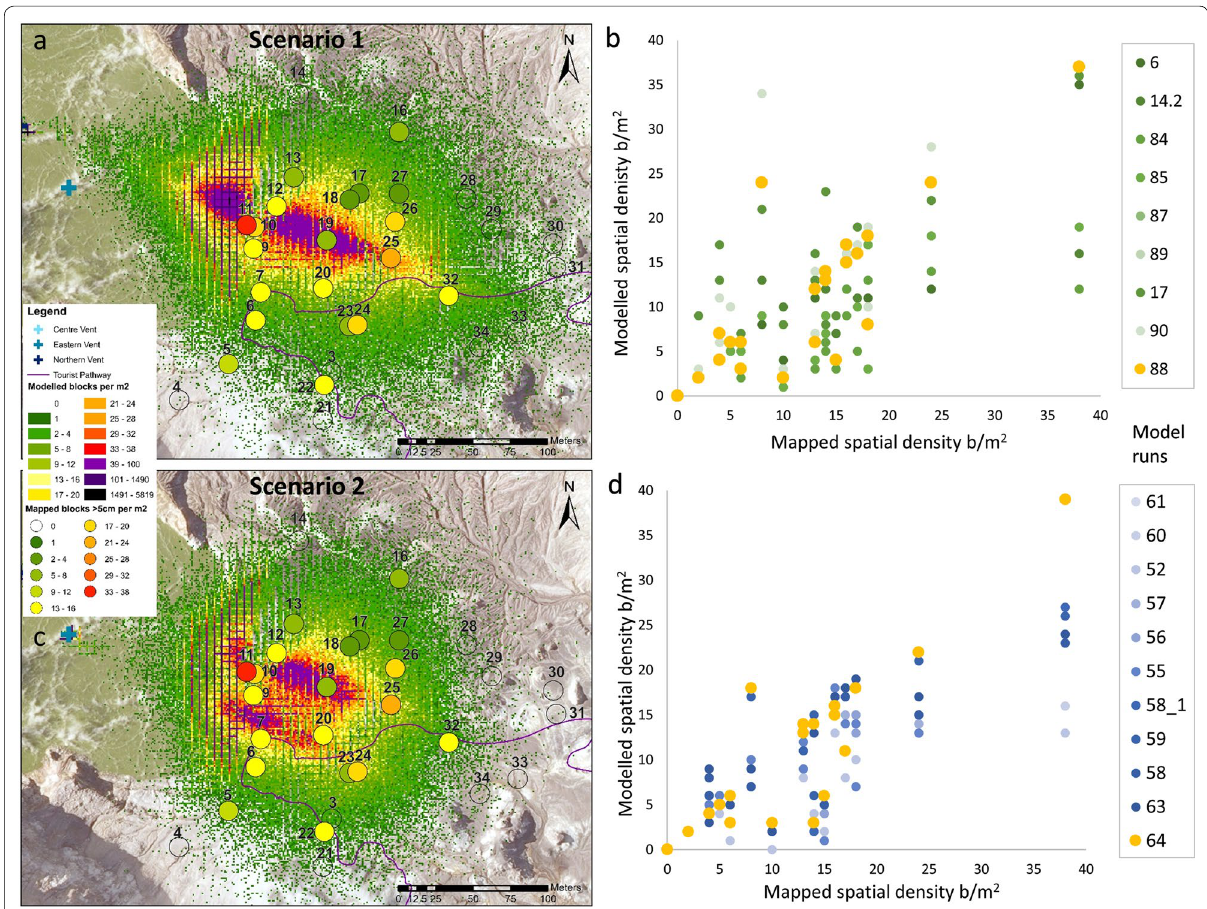
Fig. 13 a The mapped results from the best fit single eruption pulse Ballista model showing the number of modelled ballistics per square metre. The number of mapped ballistics > 5cm from Fig. 11a are also shown for comparison with the corresponding site number. b A comparison of the modelled spatial density for Scenario 1 with field spatial density at each sample location. Each example model run is shown as different coloured points, the best model iteration is shown in yellow. c The mapped results for the three-pulse scenario. d Example model iterations and best fit for the three-pulse